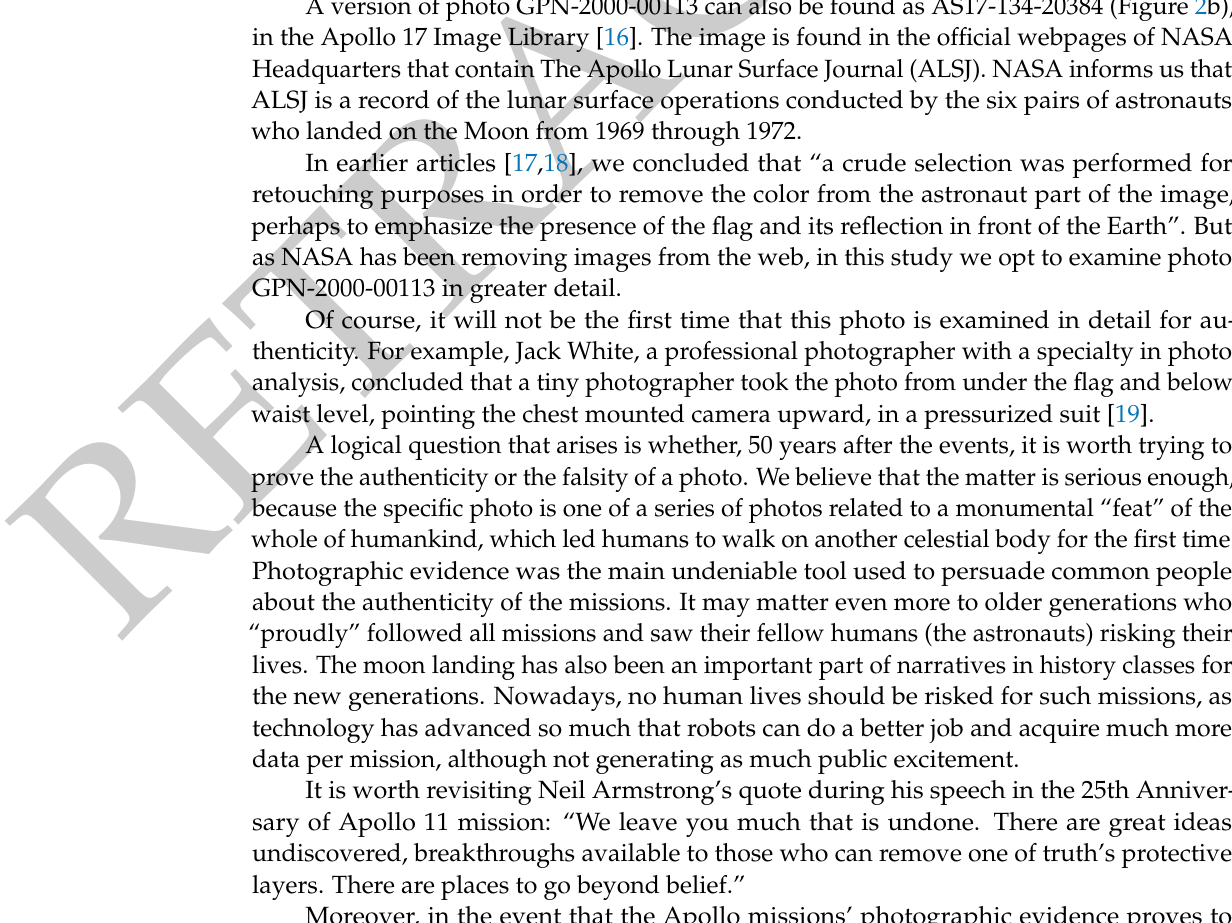
Figure 2. AS17-134-20384, found in: ( a ) the project Apollo archive of flickr.com [13]; ( b ) the Apollo 17 Image Library [16].